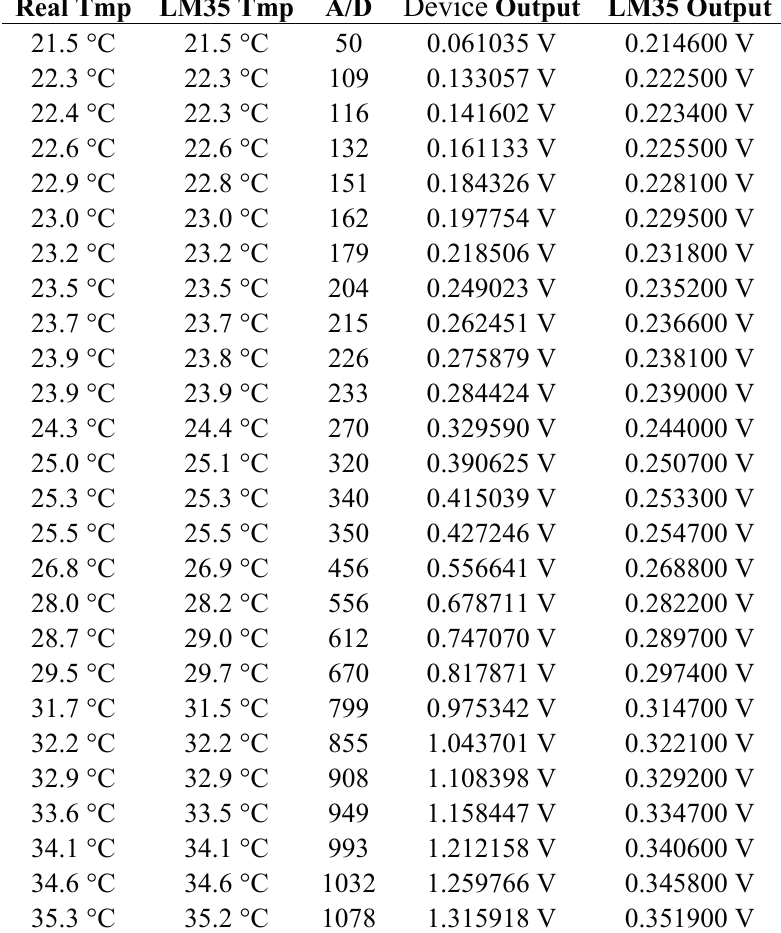
Table 2. Measured data from the device’s output, LM35 output and referential